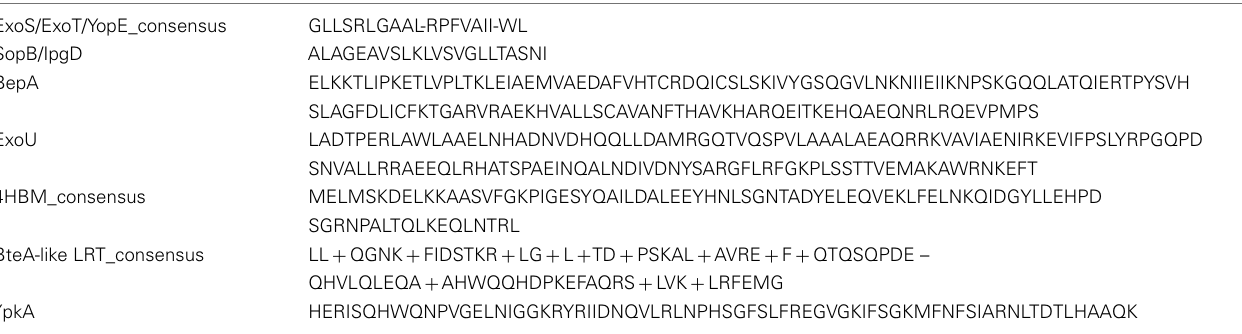
Table 2 |Amino acid sequences of the known bacterial effector-membrane localization domains a